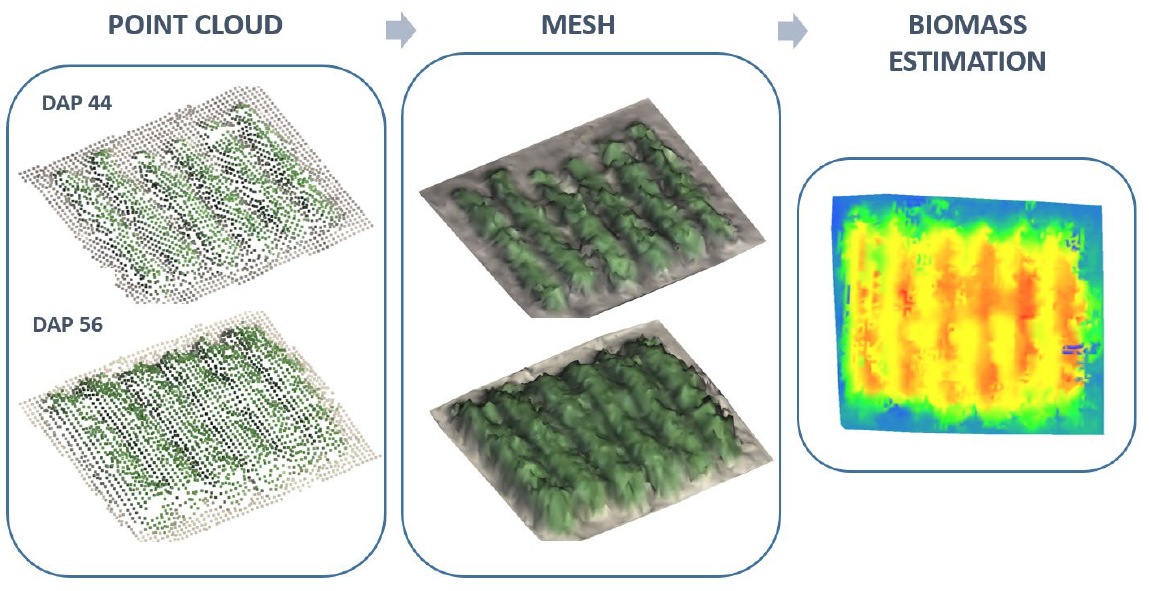
Figure 4: Biomass estimations from plots between DAP 44 and DAP